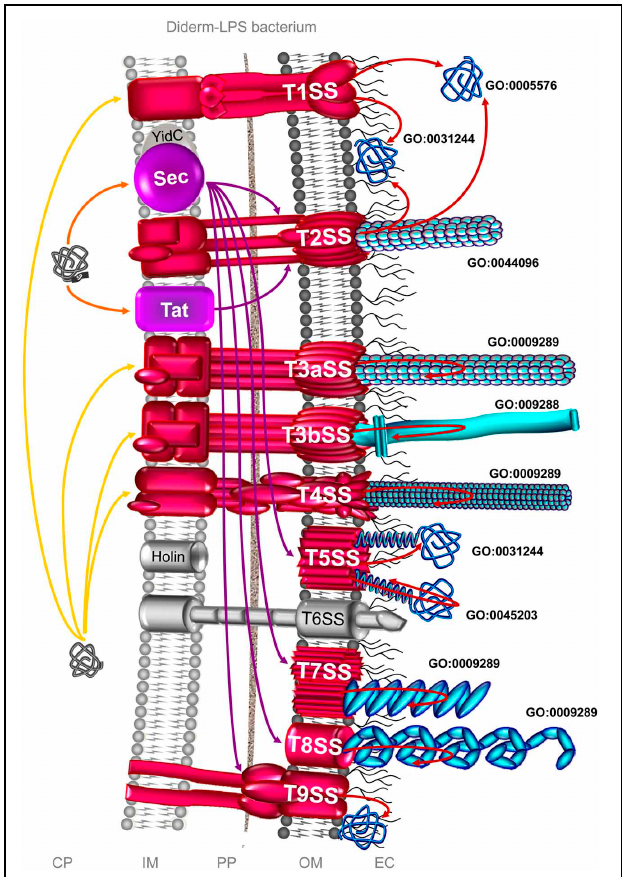
FIGURE 2 | The complement of the secretome involved in colonization process in diderm-LPS bacteria. Among the 9 distinct secretion systems through which a secreted protein can be translocated across the OM in diderm-LPS bacteria, the T1SS, T2SS, T3SS, T4SS, T5SS, T7SS, T8SS, and T9SS can be involved in colonization process (depicted in red). Translocation machineries depicted in violet are protein export pathway participating to the protein transport of effectors involved in colonization process. The T1SS can secrete adhesins, which the release into the extracellular milieu (GO:0005576) and/or the association to the external side of the OM (GO:0031244) remain to be clarified. Besides the secretion of adhesion factors, the T2SS is involved in the formation of Type 4 pilus (GO:0044096), i.e., the T2SS subfamily c (T2cSS). The subfamily a of the T3SS (T3aSS) can be involved in the formation of pilus structure (GO:0009289), i.e., either the injectisome or the Hrp (hypersensitive response and pathogenicity) pilus, whereas the subfamily b of the T3SS (T3bSS) is involved in flagellum assembly (GO:009288). The T4SS is involved in the formation of pili (GO:0009289), either pilus T (T4aSS) or pilus F (T4bSS). The T5SS is involved in the secretion of adhesion either integral (GO:0045203) or extrinsic (GO:0031244) to the OM. The T7SS (CUP; chaperone-usher pathway) is involved in the formation of Type 1 pilus, and the T8SS (ENP; extracellular nucleation-precipitation pathway) in the formation of pilus of the type curli. The T9SS (Por secretion system) can secrete adhesins involved in gliding motility. In addition, some surface proteins could use systems as yet uncovered, the so-called non-classical (NC) secretion. Only branches corresponding to the complement of the secretome involved in bacterial colonization are colored. Extracytoplasmic proteins, i.e., single proteins and supramolecular protein structures, potentially involved in surface colonization are depicted in blue. Orange and yellow arrows indicate the routes for proteins targeted to the CM possessing or lacking an N-terminal SP, respectively. Violet arrows indicate the routes for exported proteins and red arrows for secreted proteins. CP, cytoplasm; IM, inner membrane; PP, periplasm; OM, outer membrane; EC, extracellular milieu; SP, signal peptide.